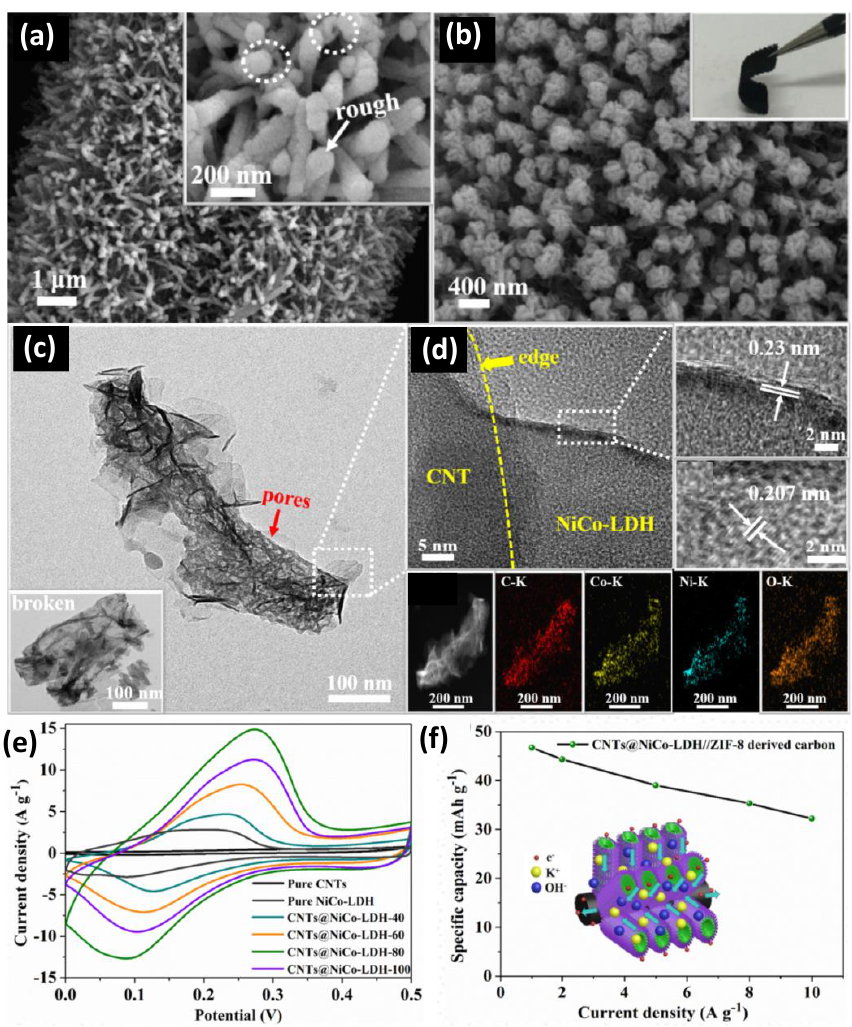
Figure 4. ( a ) ZIF-8 derived CNT arrays. ( b ) CNTs@NiCo − LDH core – shell nanotube arrays. ( c ) TEM